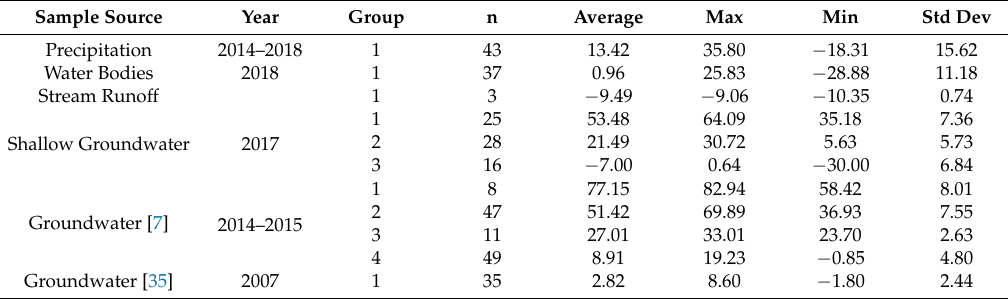
Table 4. Summary of deuterium excess in sampled water.